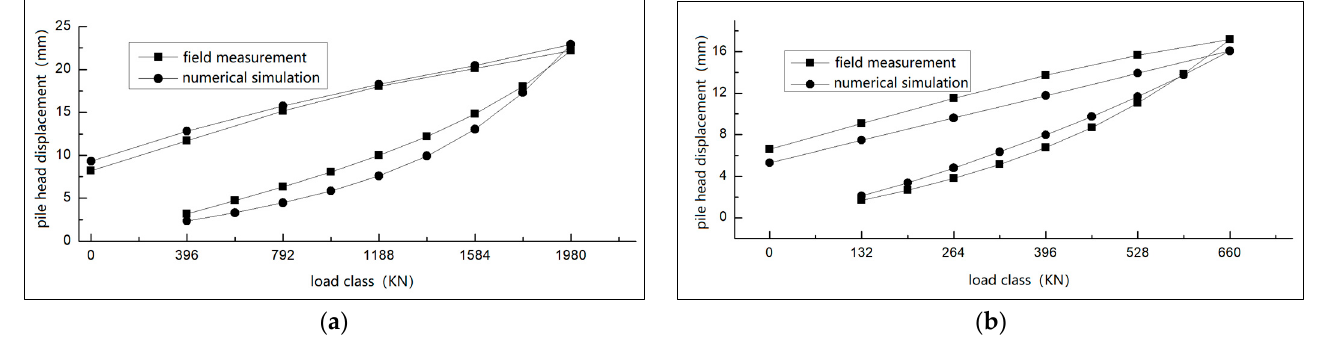
Figure 9. The load–displacement curve ( 𝐻 (cid:2868) − 𝑥 (cid:2868) ) of: ( a ) Pile 2-8#; ( b ) Pile 2-X2#.